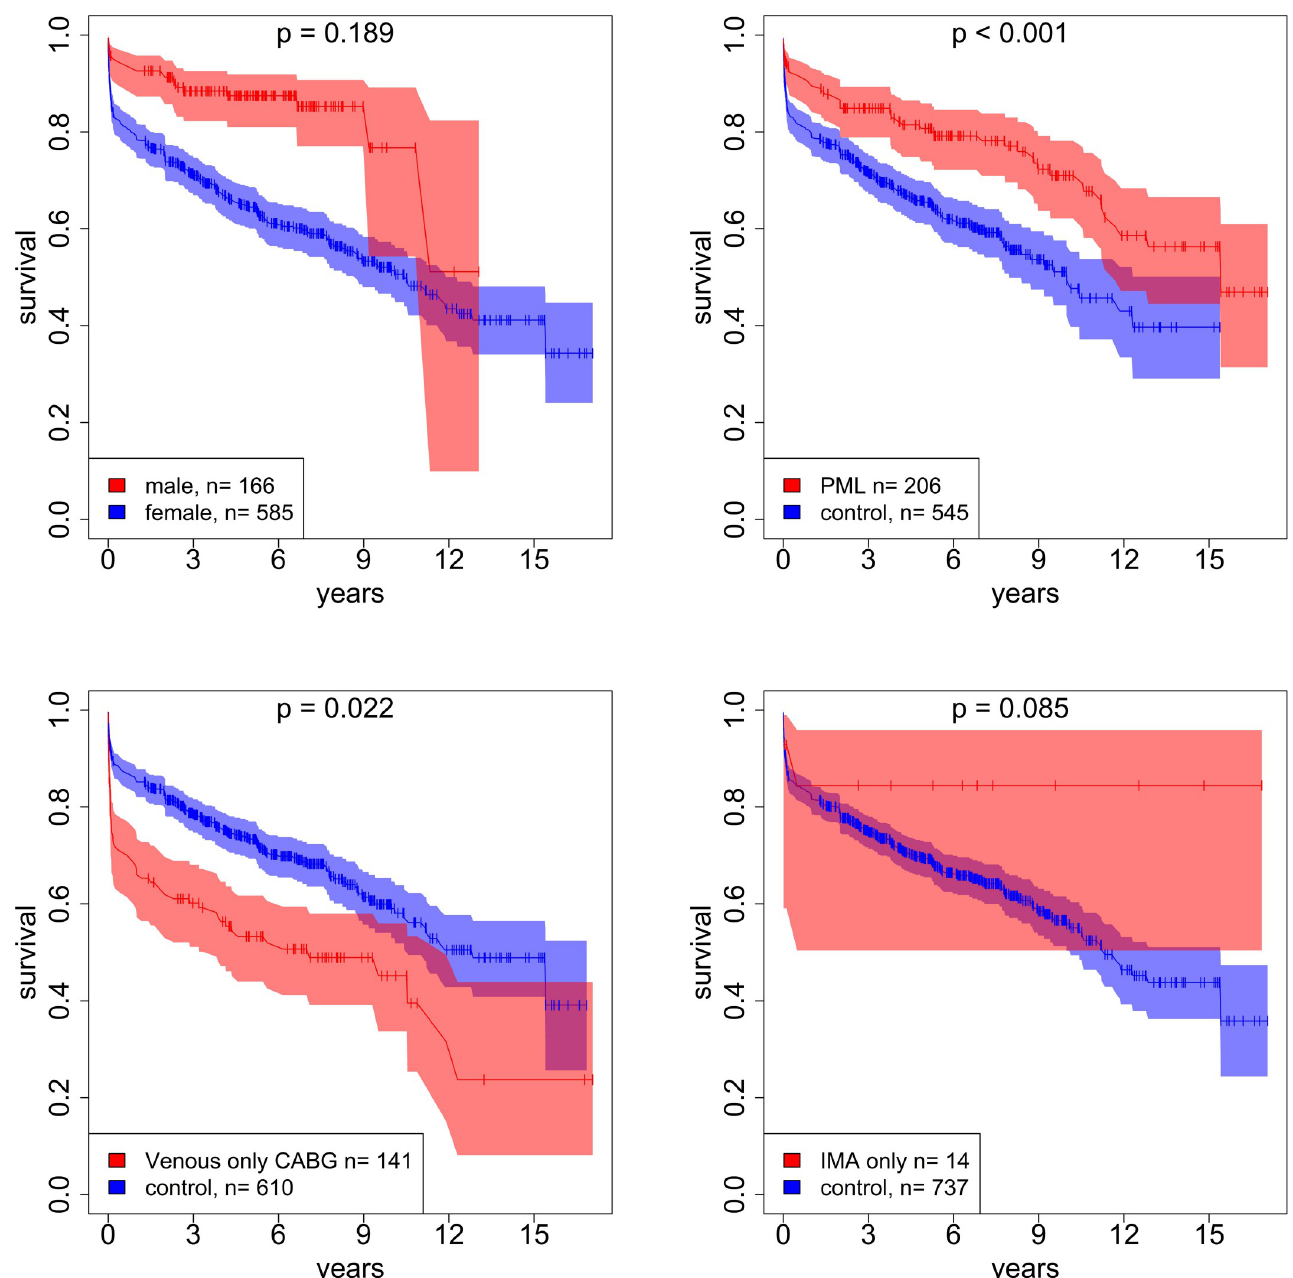
Fig 3. Procedure-related survival. MVR = Mitral valve repair; Resection = All types of resection measure on either leaflet; CABG = Coronary artery Bypass Graft; IMA = Internal mammary artery.